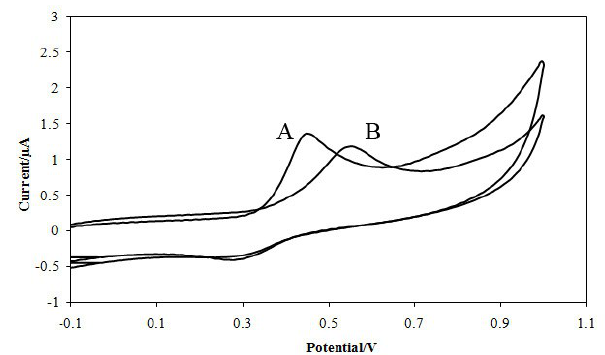
Figure 10. Cyclic voltammetry for EPR in the absence (A) and presence (B) of DNA on the surface of glassy carbon electrode. Conditions: scan rate= 100 mV s -1 , C = 10.0 μmol L -1 , EPR C = 13.8 μmol L -1 , phosphate buffer (0.1 mol L -1 , pH 7.4) and potassium chloride (0.1 DNA mol L -1